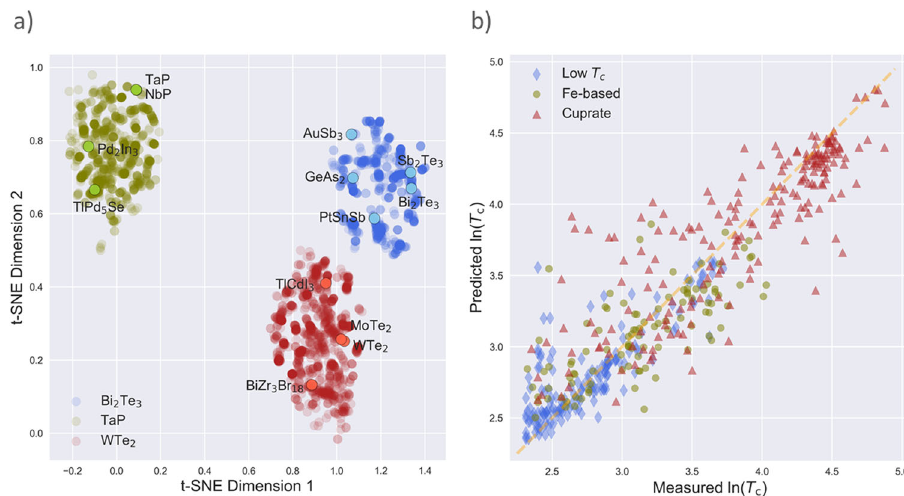
Fig. 3 Examples of machine-learning methods applied to experimental data. a Three clusters (shown with blue, green, and red), representing groups of related materials, containing topologically nontrivial materials. The materials representations are extracted from a neural network model predicting the Bravais lattice from composition — for details, see ref. 87 . The clusters can be used to search for new topological materials. b The measured vs predicted ln( T c ) of various superconductors based on a random forest model presented in ref. 91 . The same model can predict T c of several distinct superconducting classes (blue markers: low- T c materials; green markers: iron-based superconductors; red markers: cuprate